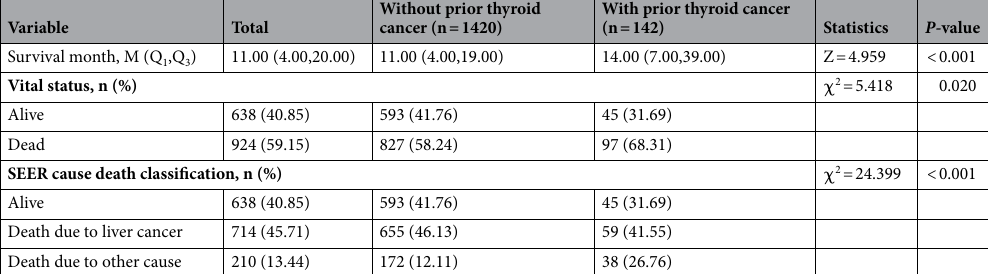
Table 1. Characteristics of the sample population. AJCC American Joint Committee on Cancer, SEER the Surveillance, Epidemiology, and End